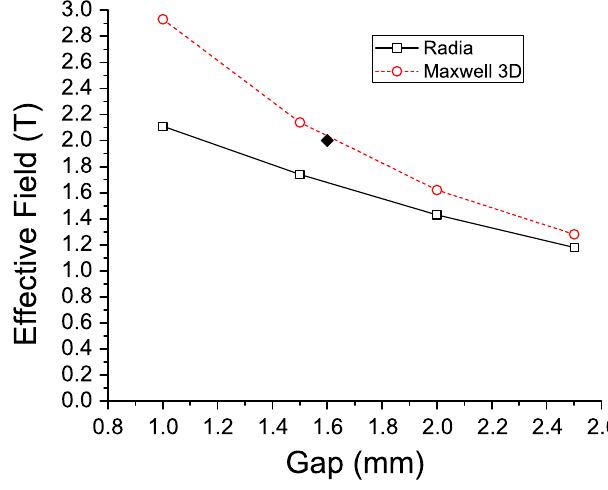
FIG. 2. (Color) Simulation results for the 9 mm period undulator when cooled to 30 K, showing the effective magnetic field, given ffiffiffiffiffiffiffiffiffiffiffiffiffiffiffiffiffiffiffiffiffi P q ð B 2 =n 2 Þ . The difference between the two curves at by B eff ¼ n large gap can be nearly entirely accounted for by the difference in simulated undulator length while segmentation limits in RADIA prevent more accurate comparison at the small gap ( < 2 mm ). The black diamond shows the assumed working point. K eff ¼ 0 : 84 B eff